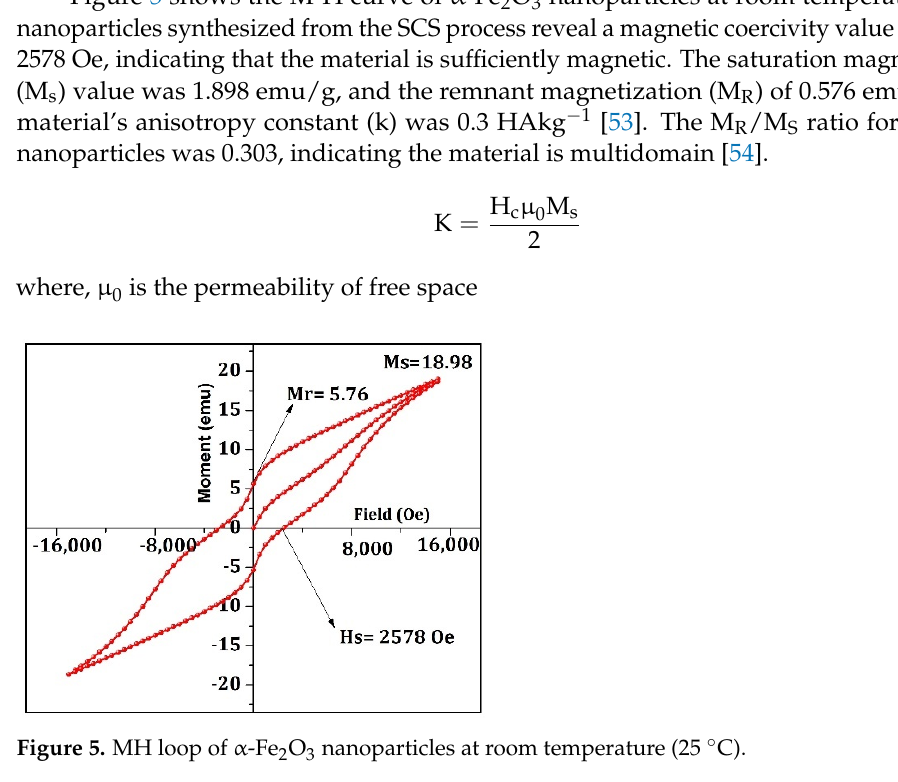
Figure 5. MH loop of α‐ Fe 2 O 3 nanoparticles at room temperature (25 °C).